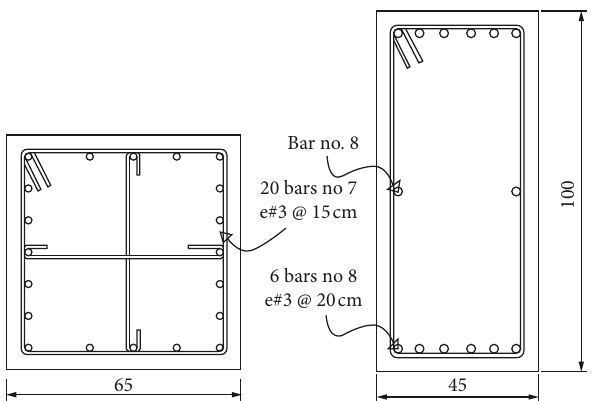
Figure 14: Optimal beam and column sections for levels 1–3 of individual 1, model